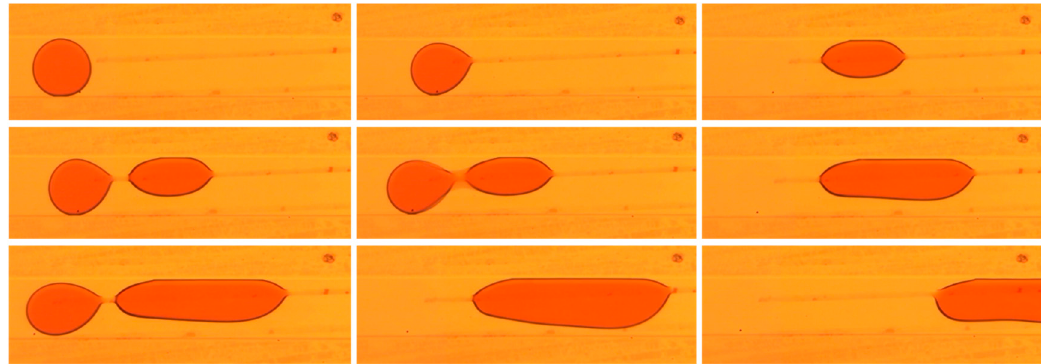
Figure 7. Coalescence and steering of disc-shaped droplets along a narrow band of GO with a width of 10 µm. The width of the channel is 200 µm.